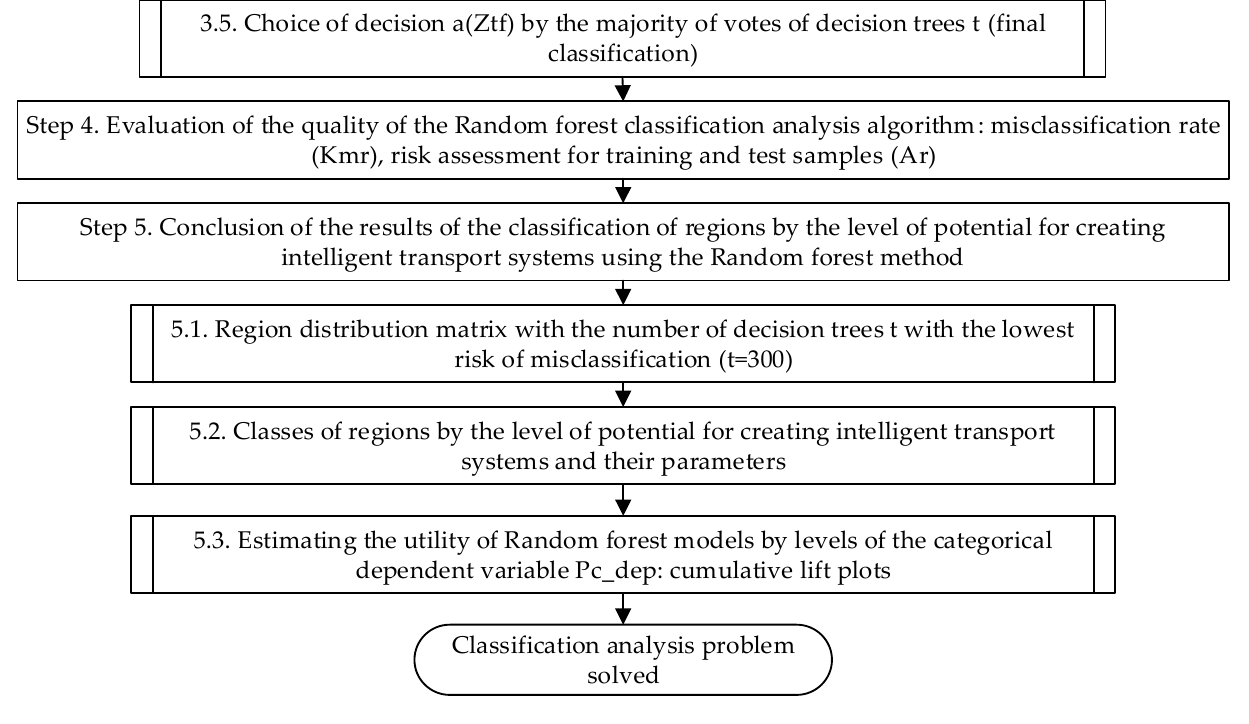
Figure 1. The author’s methodology algorithm for solving the problem of classifying objects according to their potential for creating intelligent transportation systems using random forest machine learning.